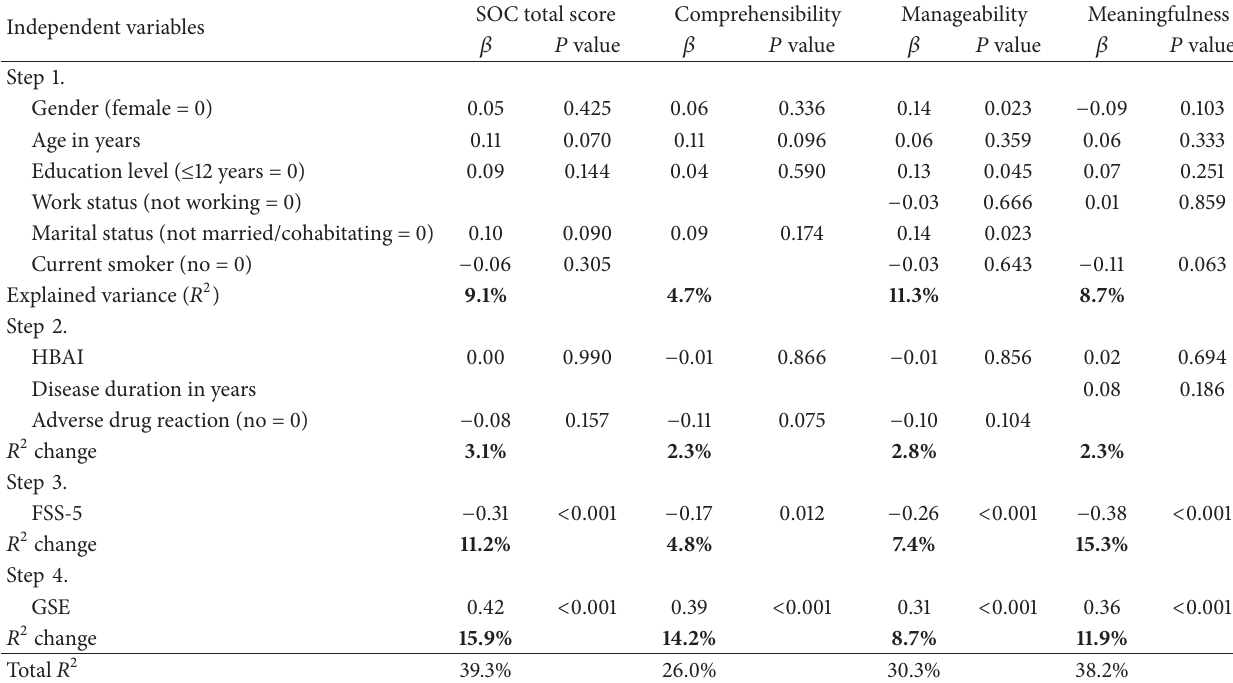
Table 5: Four independent linear regression analyses with SOC total and subdimension scores as dependent variables in patients with Crohn’s disease ( 𝑛 = 238